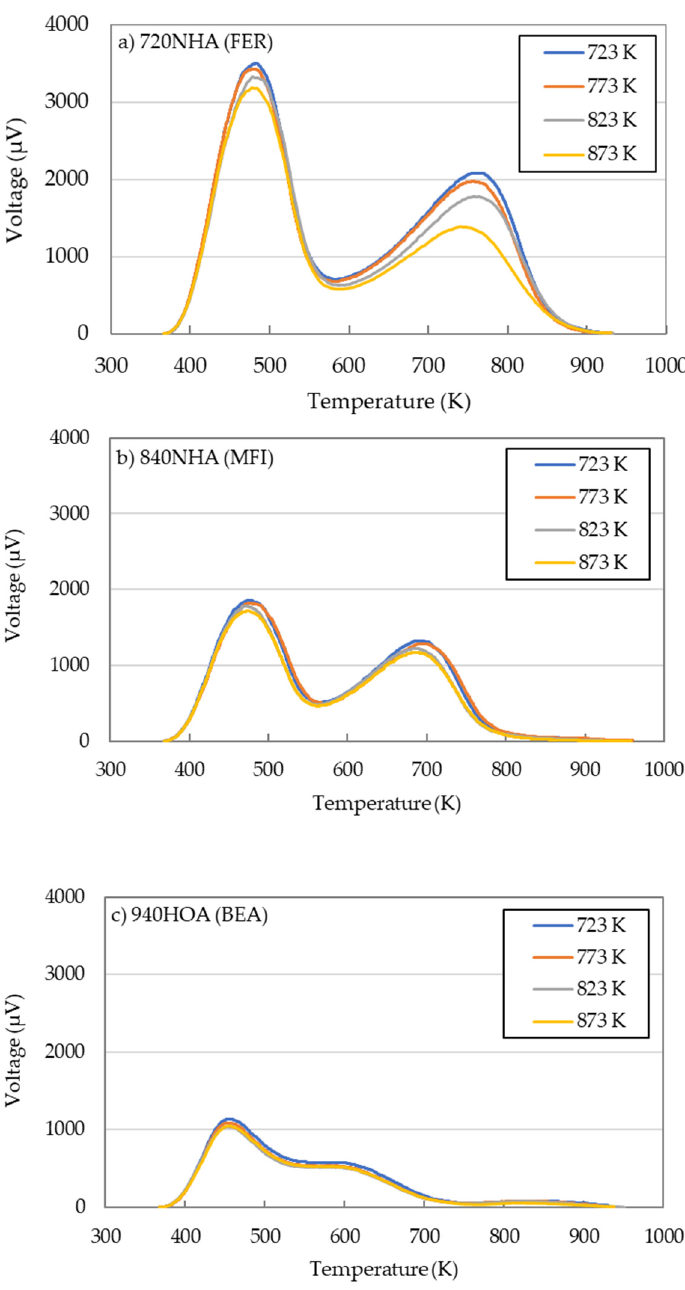
Figure 6. NH 3 -TPD profiles for three zeolites ( a ) 720NHA (FER), ( b ) 840NHA (MFI), ( c ) 940HOA (BEA) at different calcination temperatures.